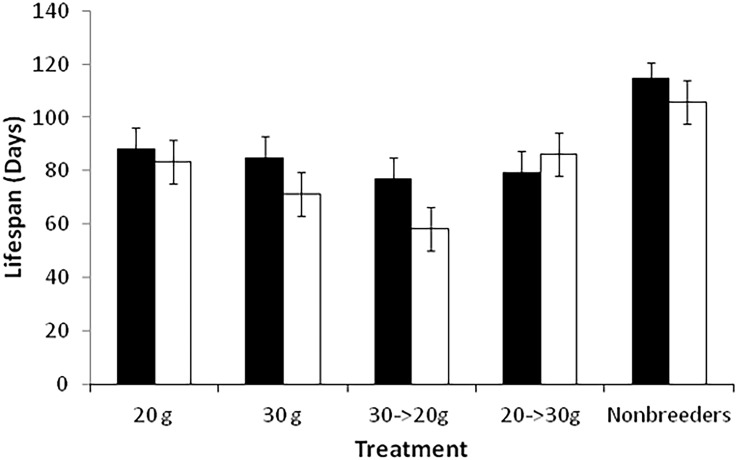
Mean (+/- 95% confidence interval) lifespan for males and females in all treatments.Males are black and females are white.